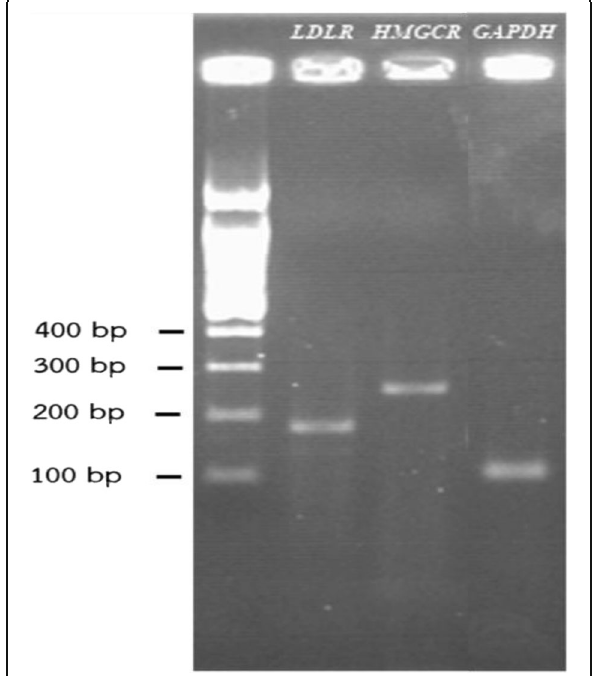
Fig. 6 Agarose gel electrophoresis (1%) of the qRT-PCR-amplified products of LDL-R , HMGCR and GAPDH . Lane 1: 100-bp DNA ladder, lane 2: LDL-R (179 bp), lane 3: HMGCR (247 bp) and lane 4: GAPDH (100 bp)